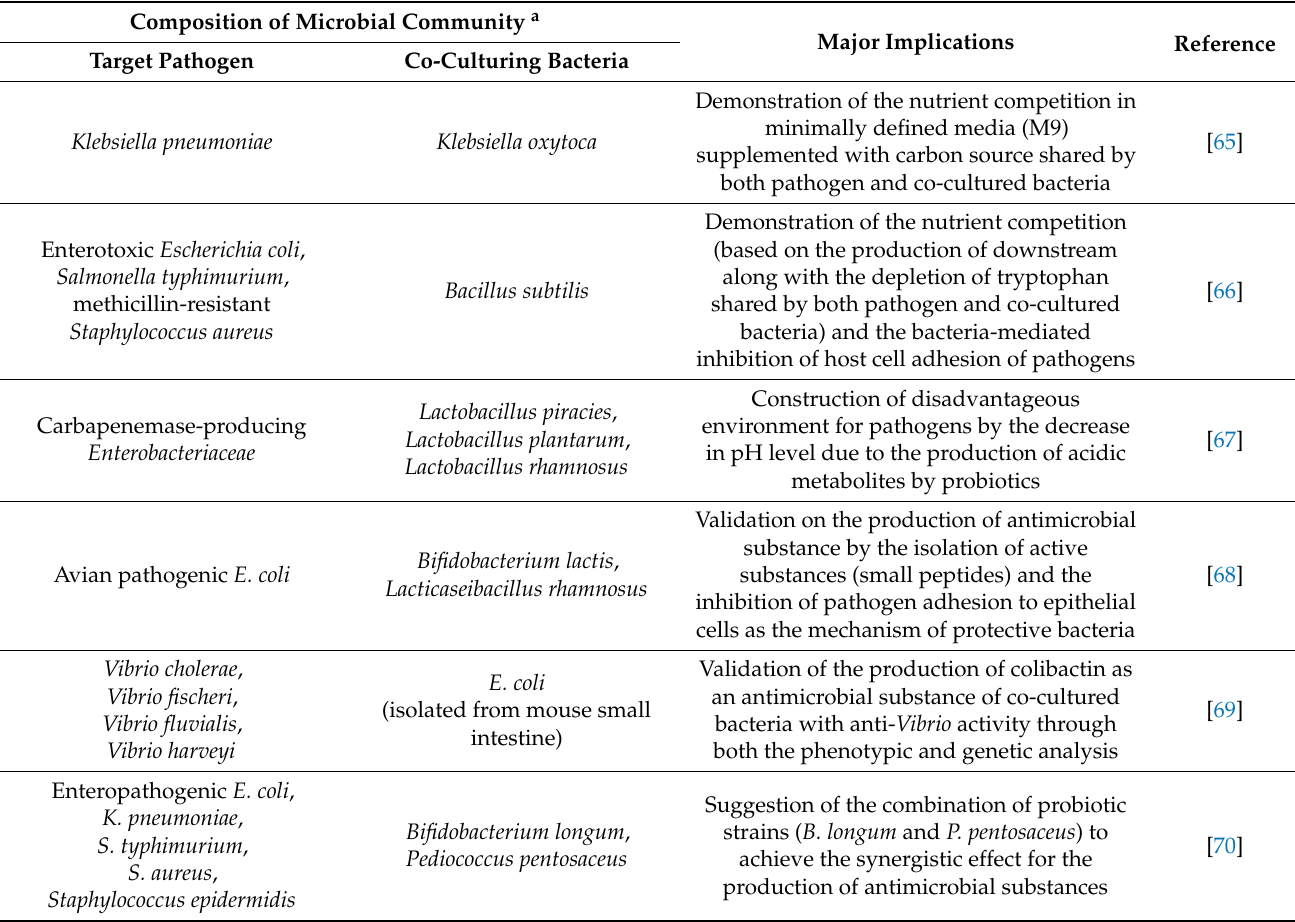
Table 3. Pathogen control strategies established from studies regarding the co-culture of pathogens with protective